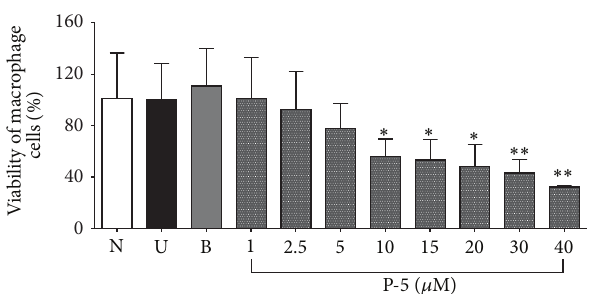
Figure1:Relativecytotoxicity(expressedin%oftheuntreatedcells) of low concentration range (1–40 𝜇 M) of P-5 towards LPS-activated mouse peritoneal macrophages. N: naive control; U: untreated control; B: budesonide (10 𝜇 M, positive control). Shown is the mean of three different experiments ± S.D. ANOVA of P-5 cytotoxicity was F 10,48 = 5.32, 𝑝 < 0.00001 . ∗ 𝑝 < 0.05 ; ∗∗ 𝑝 < 0.01 compared to untreated macrophages.